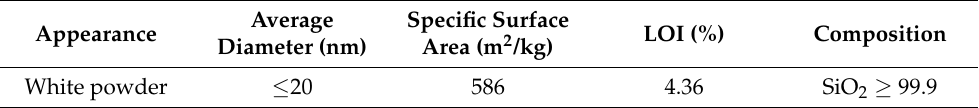
Table 2. Properties of used nano-SiO 2